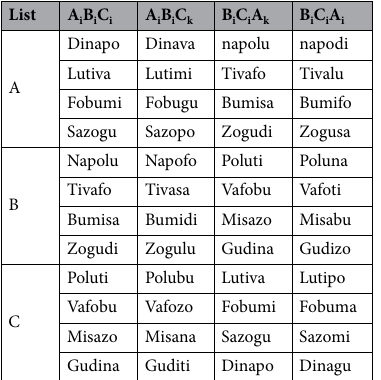
Table 1. Stimuli. Triplets for each condition (Words, Edge-words, Part-words, and Non-words) used for each of the three lists. Note that Words, Part-Words, and Edge-words are swapped between lists (Non-words and Words share the same syllables) to control for any acoustic differences between conditions. One list was randomly selected for each